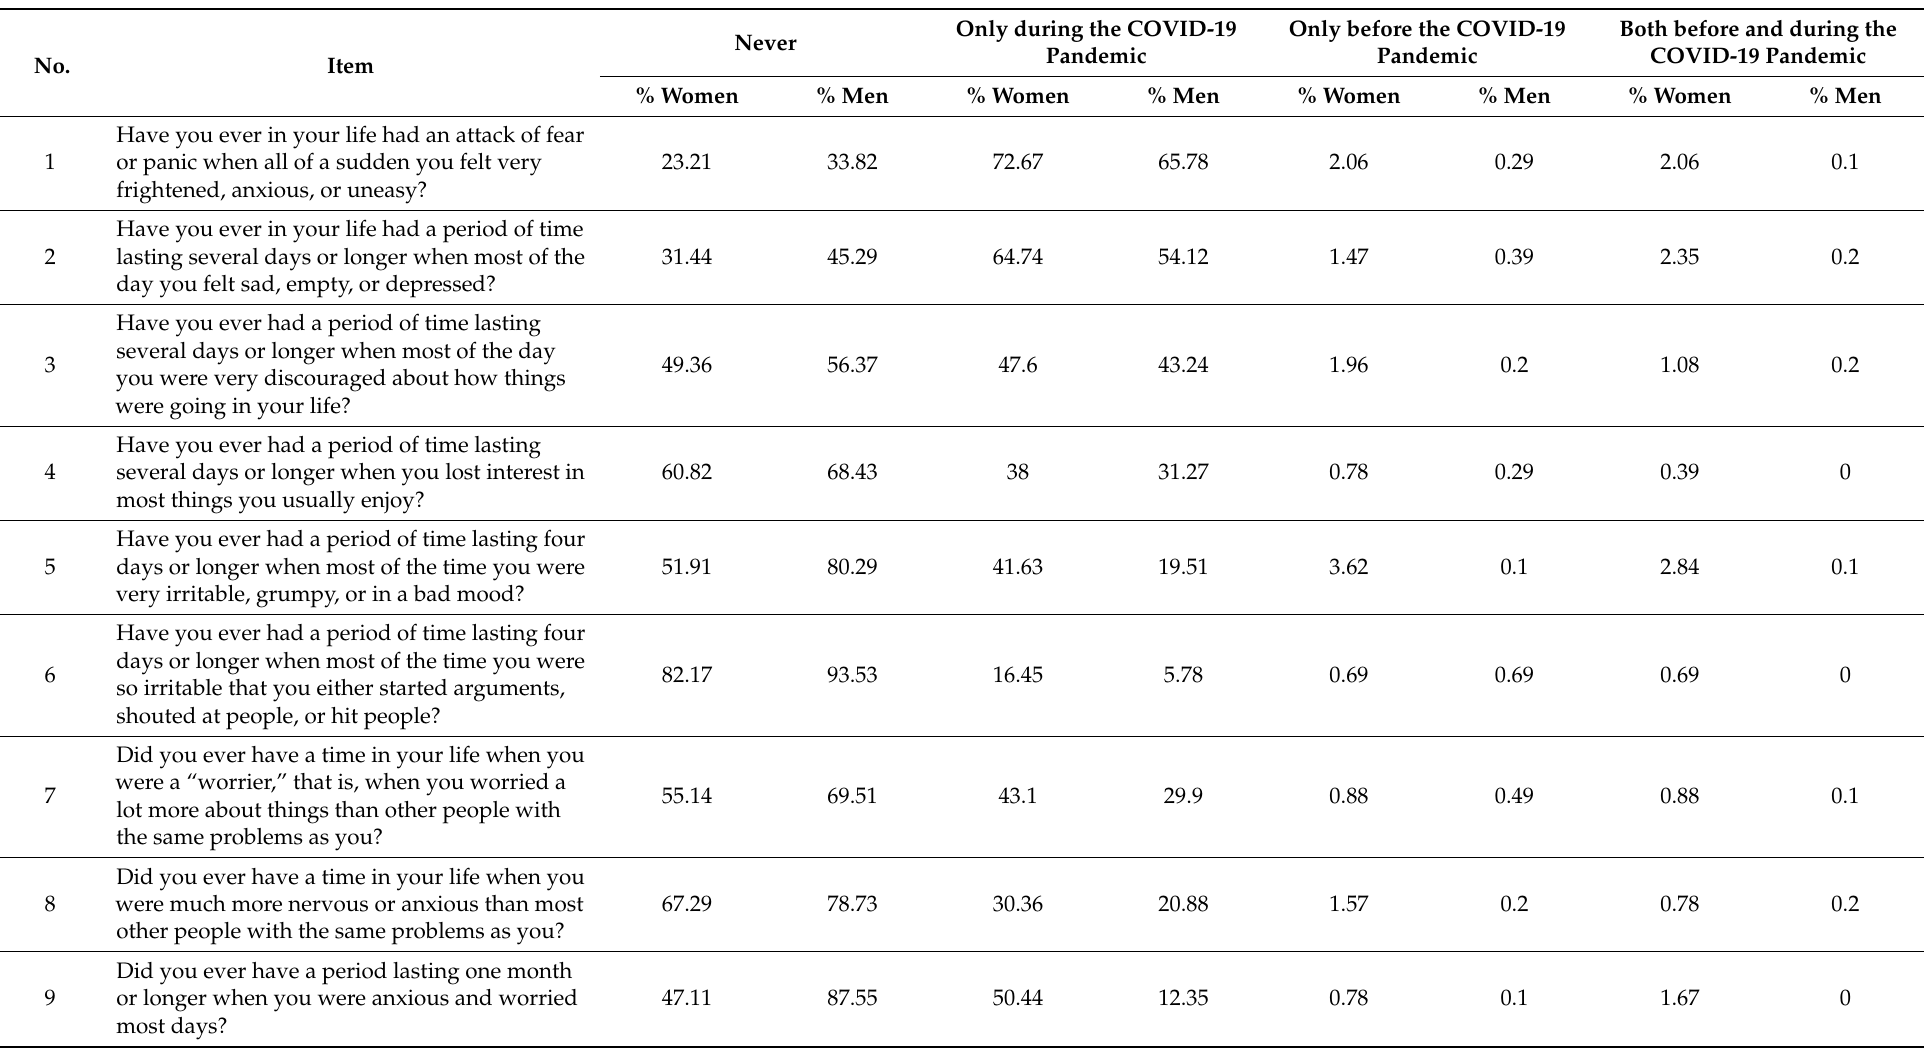
Table 2. Percentwise distribution of items that measured mental health